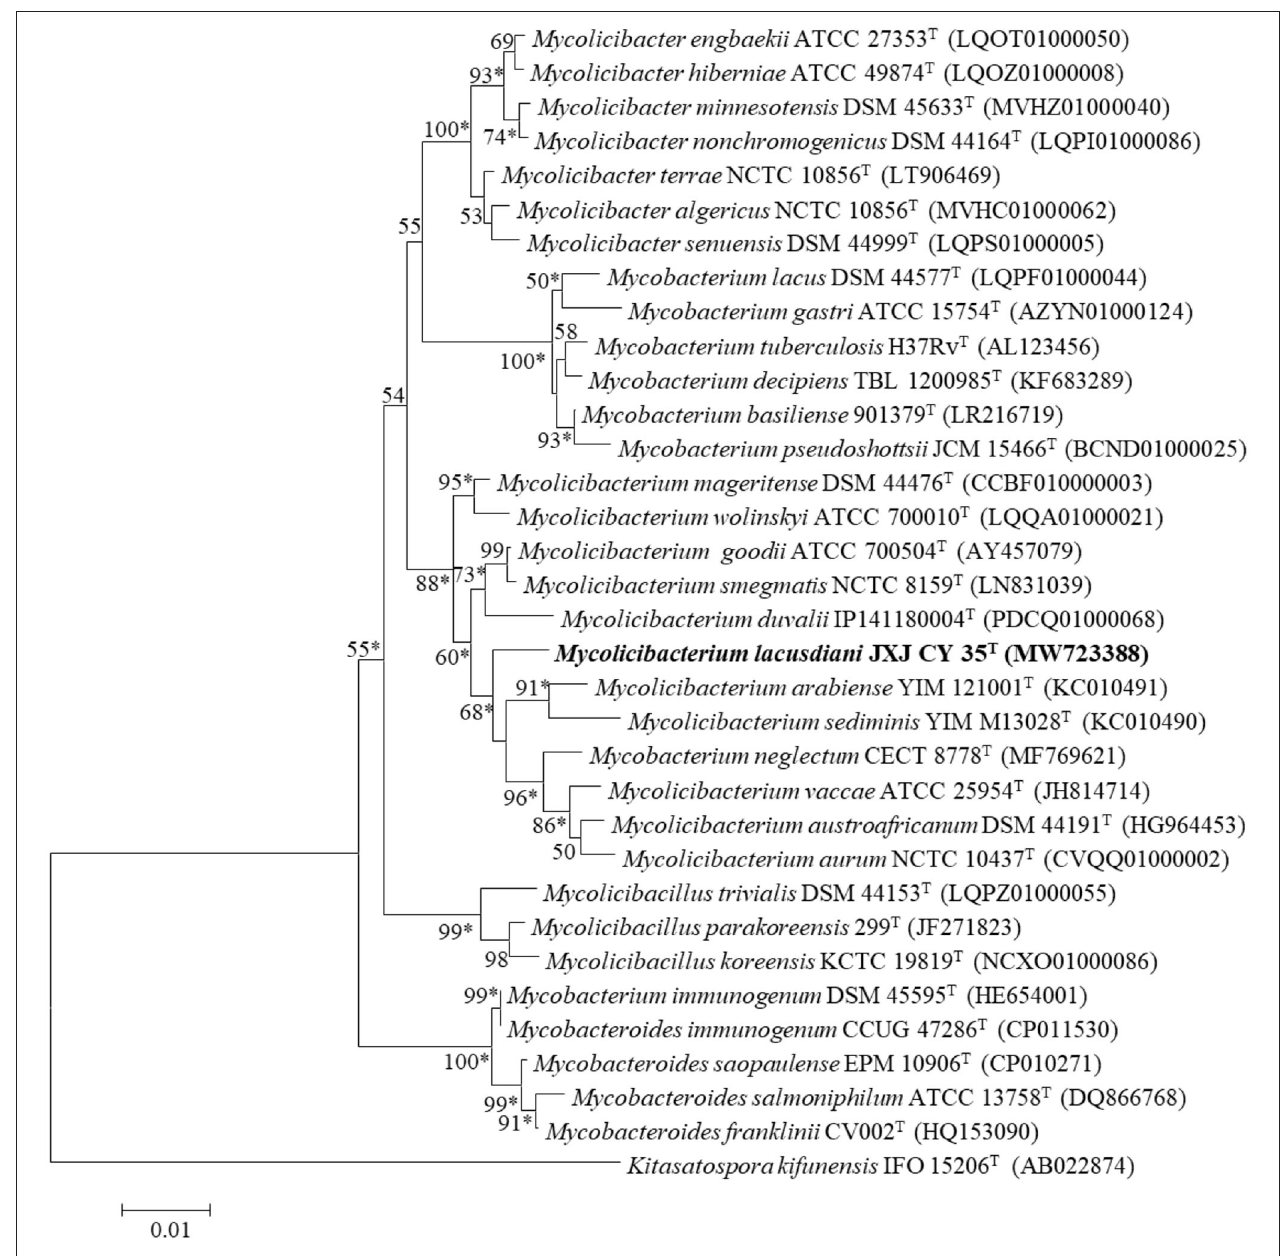
FIGURE 2 | Neighbor-joining phylogenetic tree based on 16S rRNA gene sequences of strain JXJ CY 35 T , its closest relative species of the genus Mycolicibacterium , and type strains of other genera. * Indicates clades that were conserved in neighbor-joining, maximum-likelihood, and maximum-parsimony trees. Bootstrap values (expressed as percentages of 1,000 replications) > 50% are given at nodes. Scale bar: 0.01 sequence